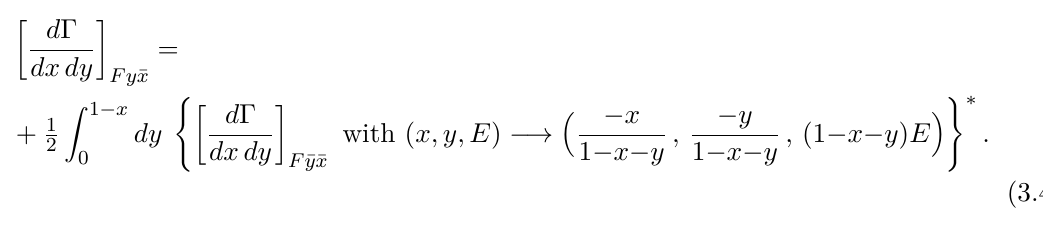
moves two emissions ( x and y ) from amplitude to conjugate amplitude: